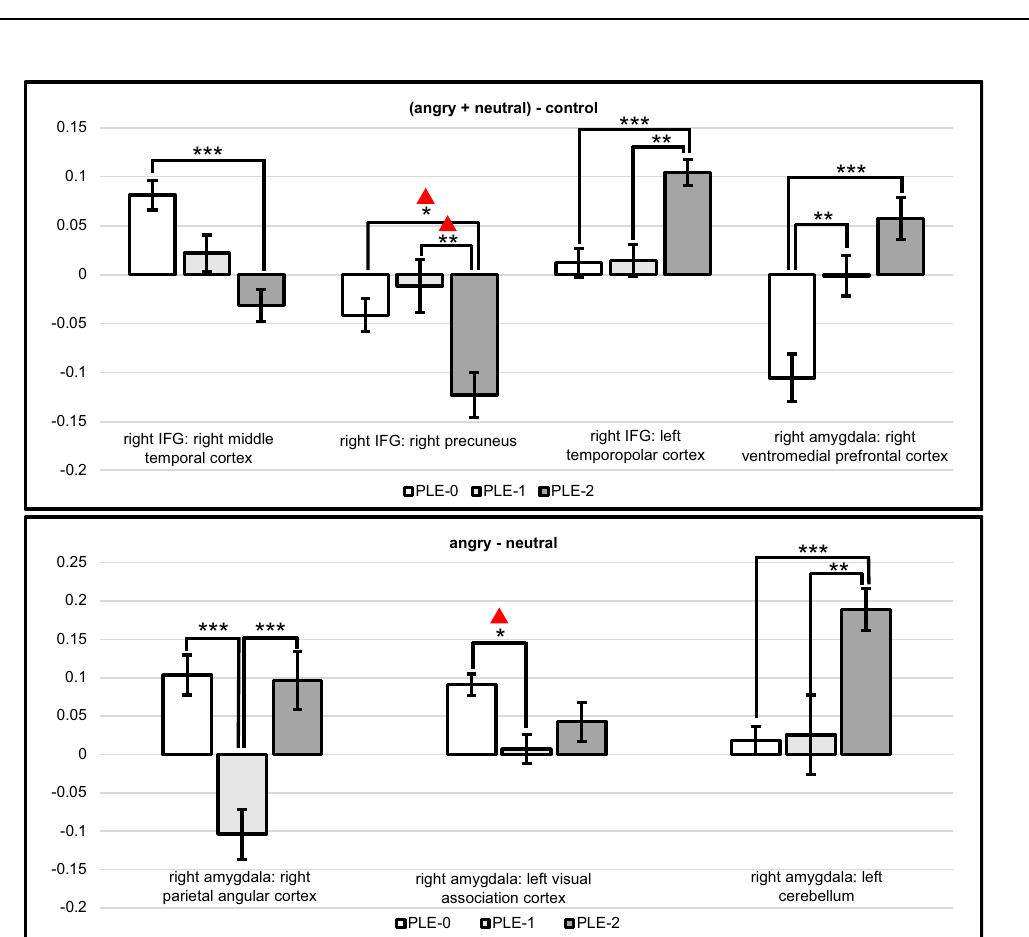
This table shows the results of the seed-to-voxel functional connectivity analysis for the different contrasts. The names of the selected seeds are presented with the corresponding voxels and their MNI coordinates, peak F value, and cluster size. BA Brodmann area.